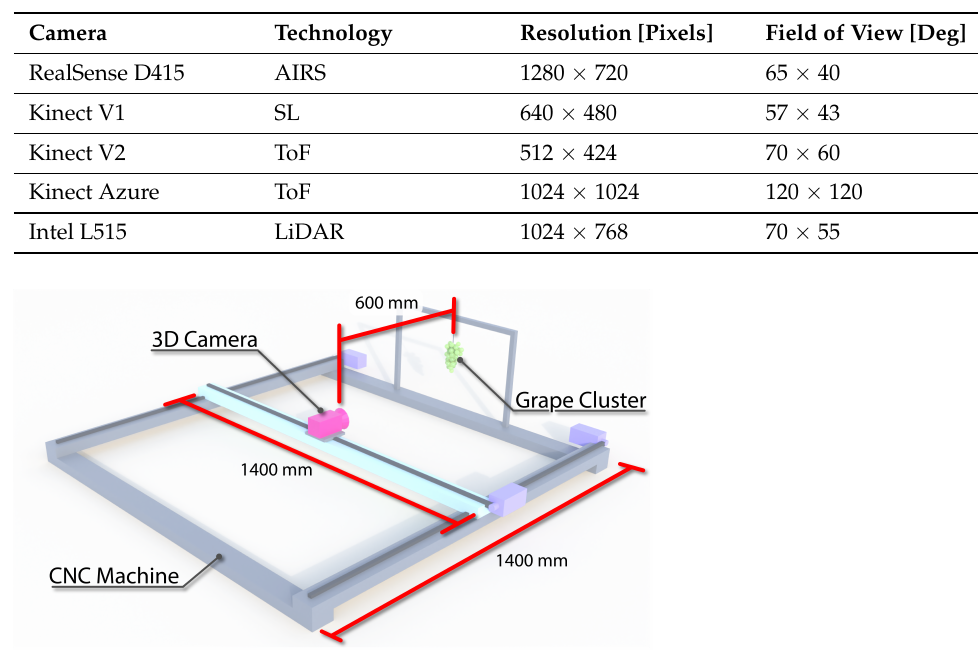
Table 1. List of RGB-D cameras used with the depth measurement technologies they use and their resolution and field of view specifications.